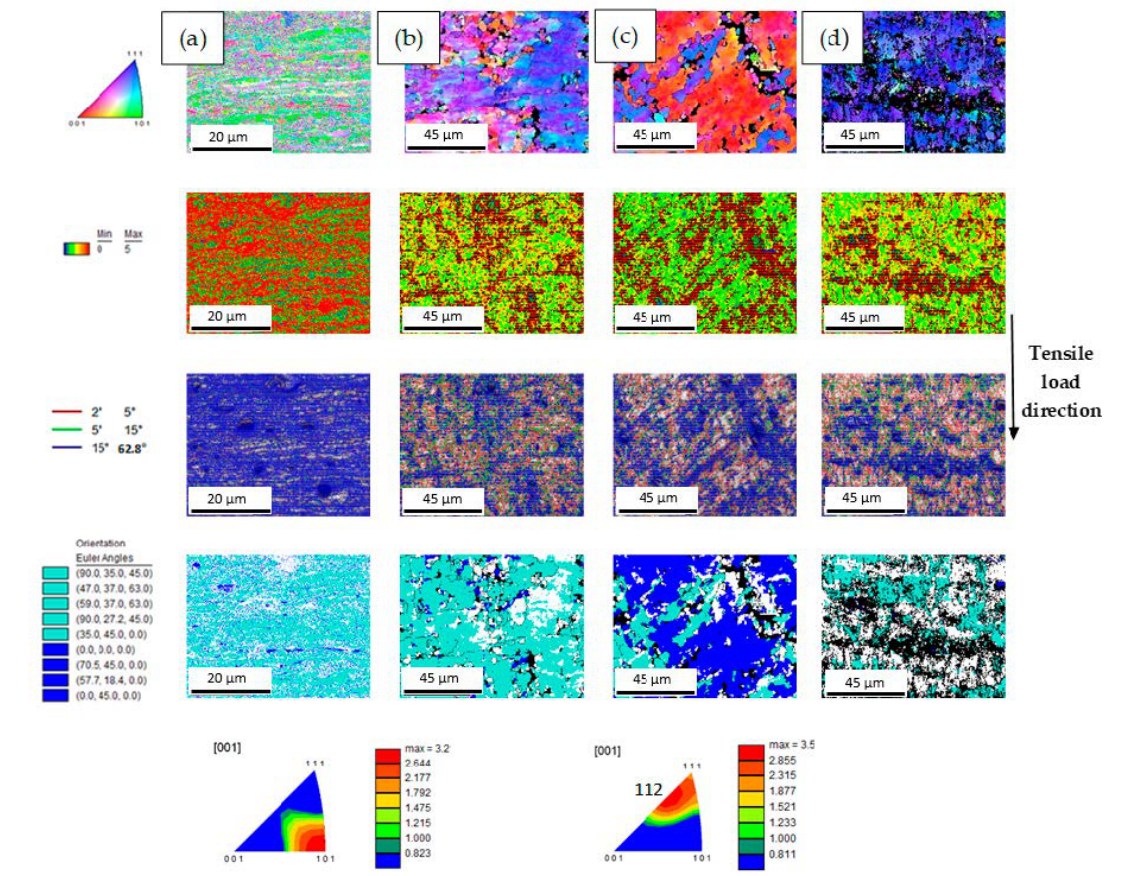
Figure 10. EBSD scans and respective maps for sample ( a ) column CRAR, ( b ) CRPAR, ( c ) CR45 and ( d ) CRTRA. Table 4. KAM values, misorientation, and texture components of the cold ‐ rolled sheet sample.